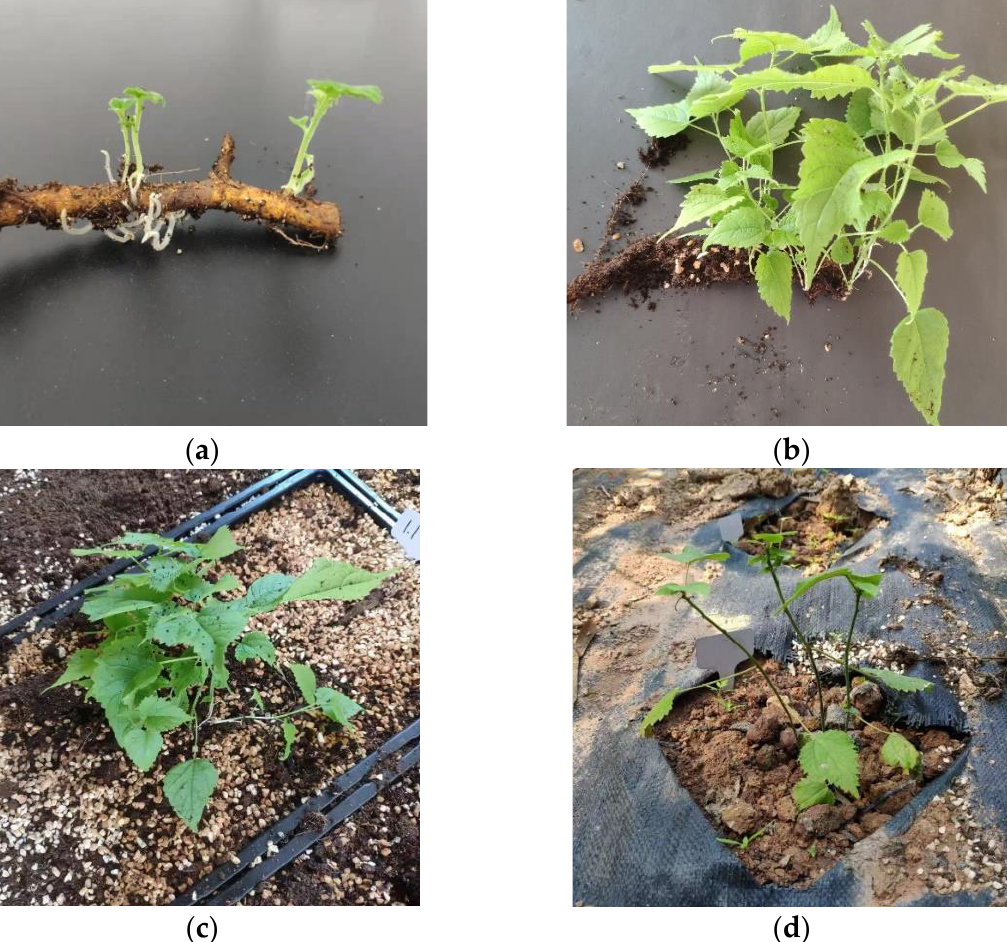
Figure 3. Routine observation on root propagation of Broussonetia papyrifera . ( a ) adventitious shoot formation stage of mother root; ( b ) adventitious shoot growth; ( c ) plantlets were transplanted from Hoagland nutrient to mixed substrate (perlite:peat soil = 1:1) for growth; ( d ) growth stage of domes- tication and the transplanting field.